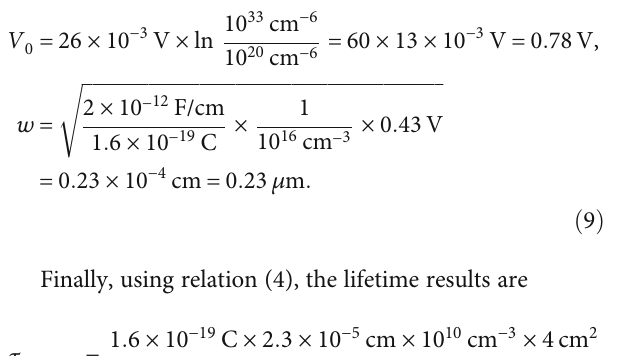
Table 1: Determination of the parameters of a photovoltaic solar